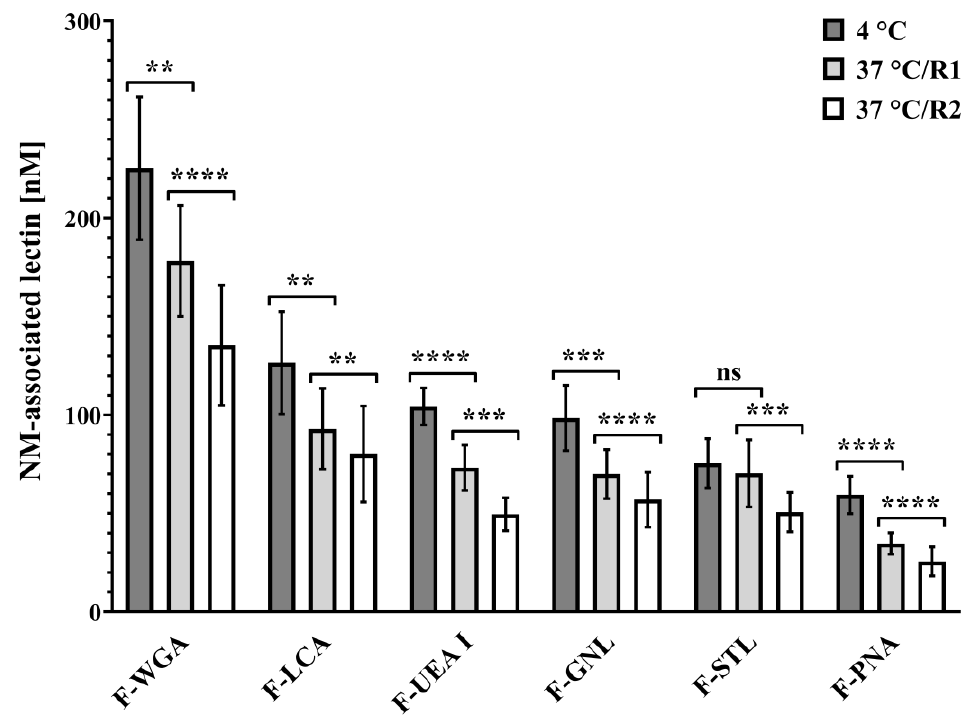
Figure 4. Influence of temperature increase and washing procedure on lectin-cell association. Values obtained at 37 °C were measured before (37 °C/R1) and after washing (37 °C/R2). ns (not significant) p > 0.05; ** p ≤ 0.01; *** p ≤ 0.001; and **** p ≤ 0.0001.